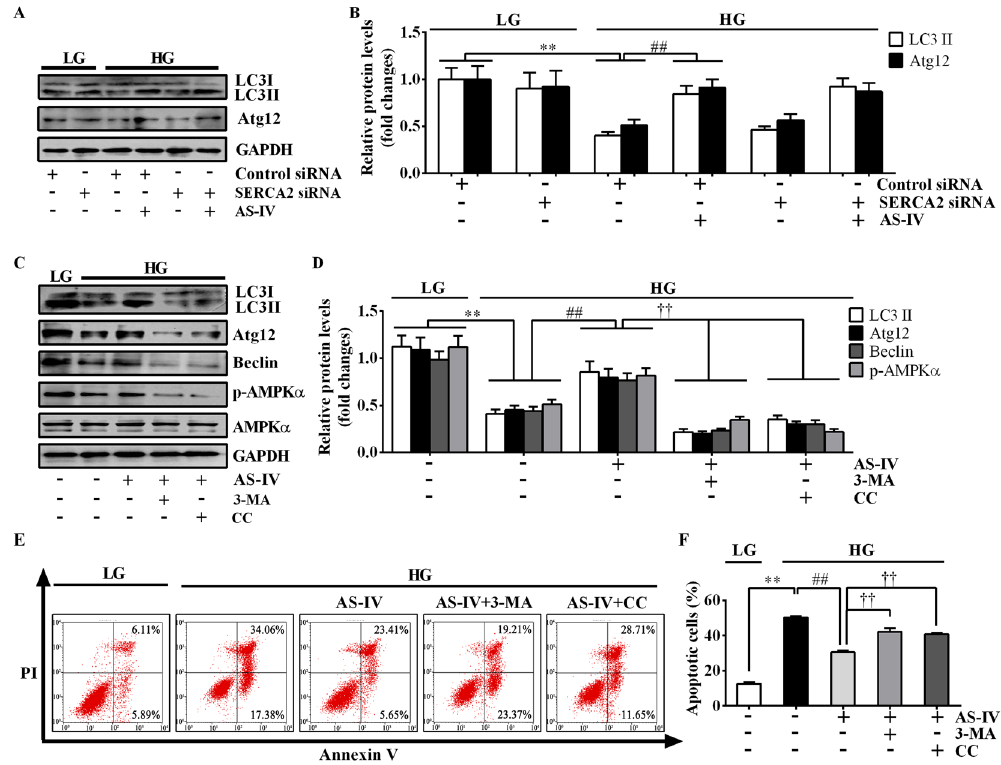
Figure 9. AMPK α mediated the beneficial effect of AS-IV on HG-induced autophagy defect. ( A , B ) Podocytes were transfected with control siRNA or specific SERCA2 siRNA for 6 h, and then treated with HG in the presence or absence of 80 μ M AS-IV for 72 h. ( A ) Representative immunoblots of LC3 and Atg12 under different conditions as indicated. ( B ) Densitometric quantification of LC3-II and Atg12 as shown in panel A. Data are expressed as mean ± SEM. n = 3. ** P < 0.01 compared to LG plus control siRNA group. ## P < 0.01 compared to HG plus control siRNA group. ( C – F ) Podocytes were treated with HG in the presence or absence of AS-IV (80 μ M) or the autophagy inhibitor 3-MA (1 mM) or the AMPK inhibitor CC (1 μ M) for 72 h. ( C ) Representative immunoblots of LC3, Atg12, Beclin and p-AMPK α under different conditions as indicated. ( D ) Densitometric quantification of LC3, Atg12, Beclin and p-AMPK α as shown in panel C. ( E ) Representative flow cytometry results for podocytes cultured under different conditions as indicated. ( F ) Quantitative analysis of apoptotic cells determined by flow cytometry as shown in panel E. Data are expressed as mean ± SEM. n = 3. ** P < 0.01 compared to LG group. ## P < 0.01 compared to HG group. †† P < 0.01 compared to HG plus AS-IV group. The original blots for panel A and C were presented in Supplementary Figure S10. One-way ANOVA and Newman-Keuls multiple comparisons test ( B , D , F ). LG, low glucose; HG, high glucose; 3-MA, 3-methyladenine; CC, compound